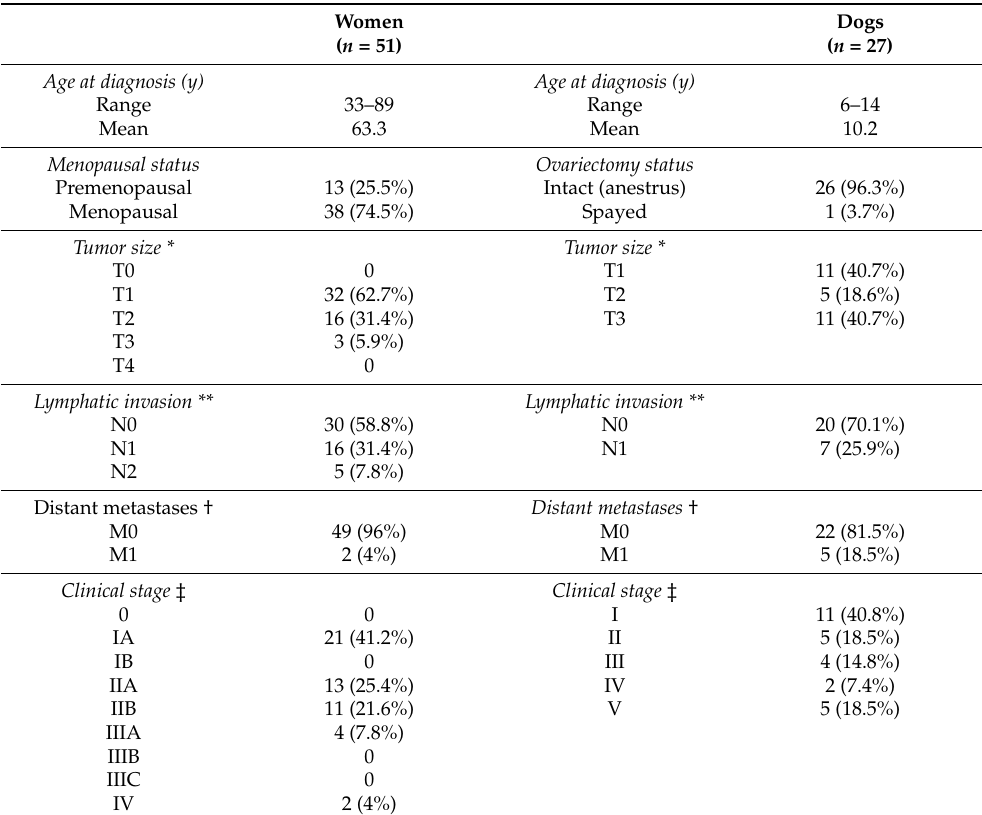
Table 1. Epidemiological and clinical information of the women and dogs with breast or mammary cancer prospectively collected for inclusion in the